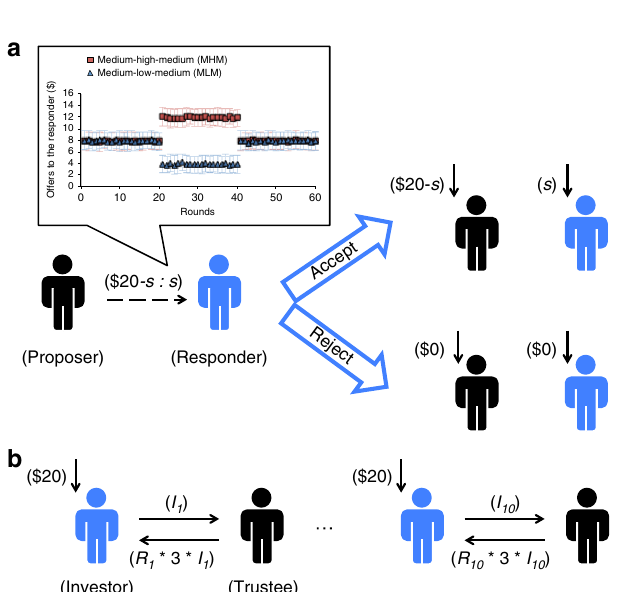
Fig. 1 The ultimatum game (UG) and multi-round trust game (MRT) in the current study. a Procedure for UG comprising of 60 rounds, with Mean and SD of offer size in each round across Medium-Low-Medium (MLM) or Medium-High-Medium (MHM) conditioning type. Each participant was told he/she was the Responder in this game who decided to accept or reject the offer ( s ) from different Proposers in each round. Offers were sampled from one of the three Gaussian distributions: low offers (mean